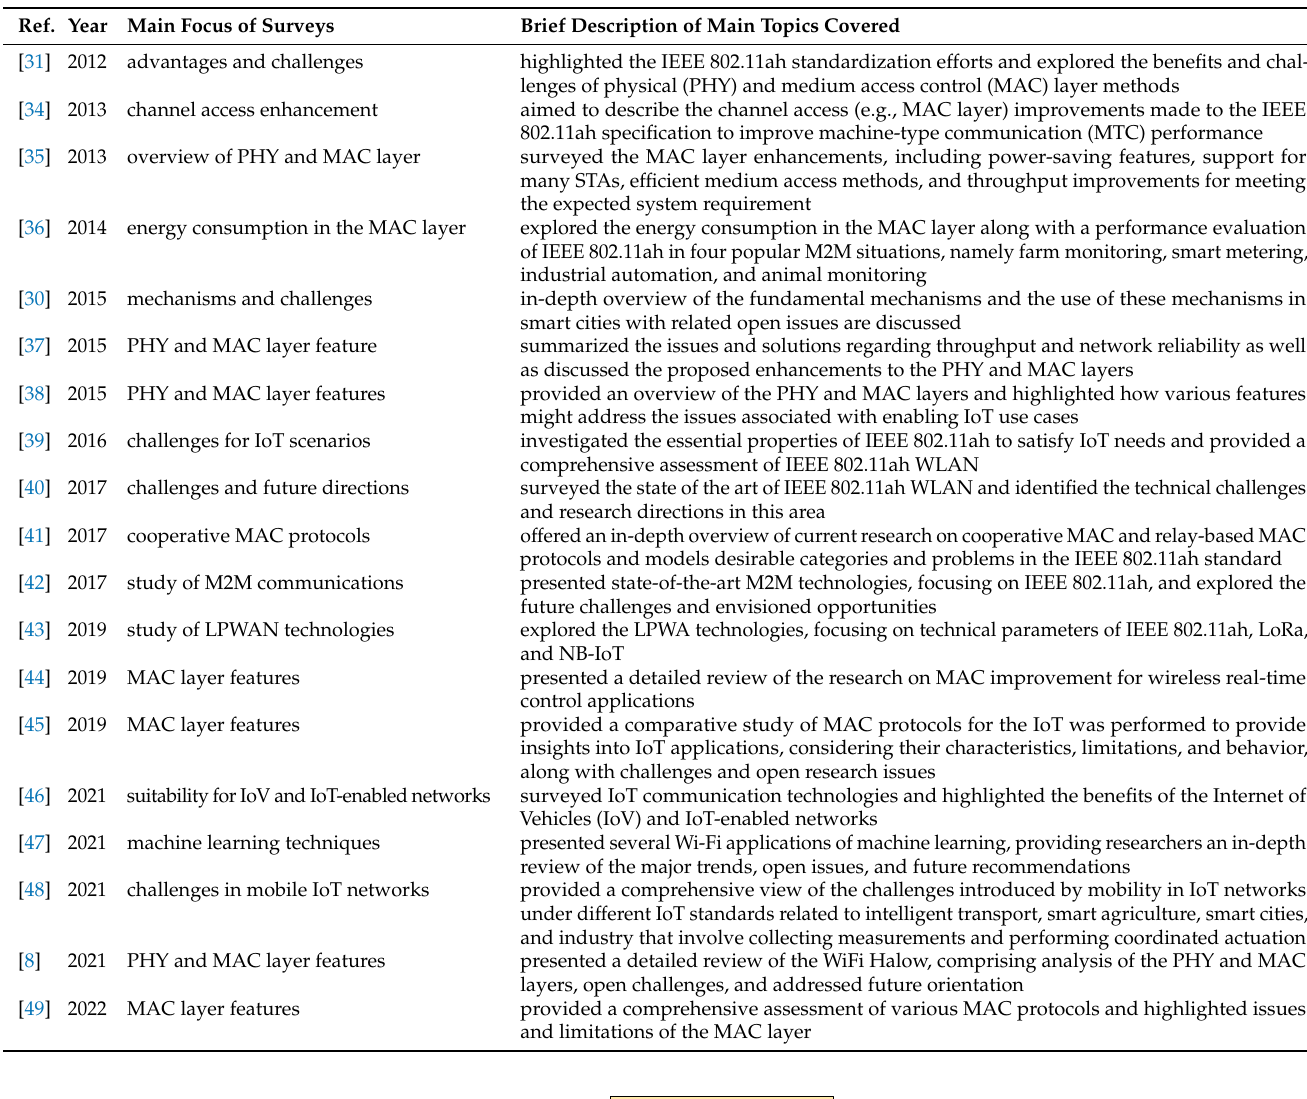
Table 2. A brief summary of existing IEEE 802.11ah WLAN surveys and tutorials.